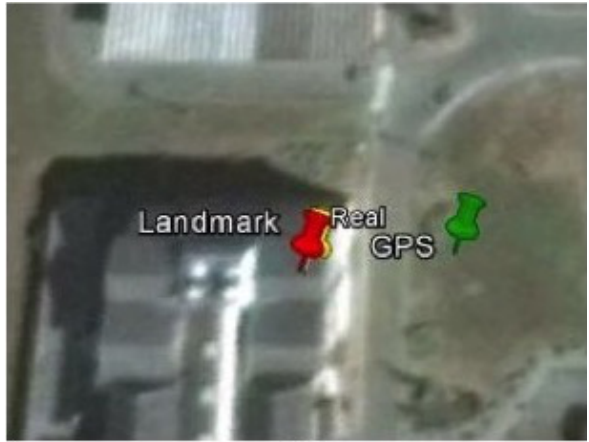
Figure 7. Auto-localization position comparison between GPS, Landmark Recognition Estimation, Real UAV Position in the rooftop